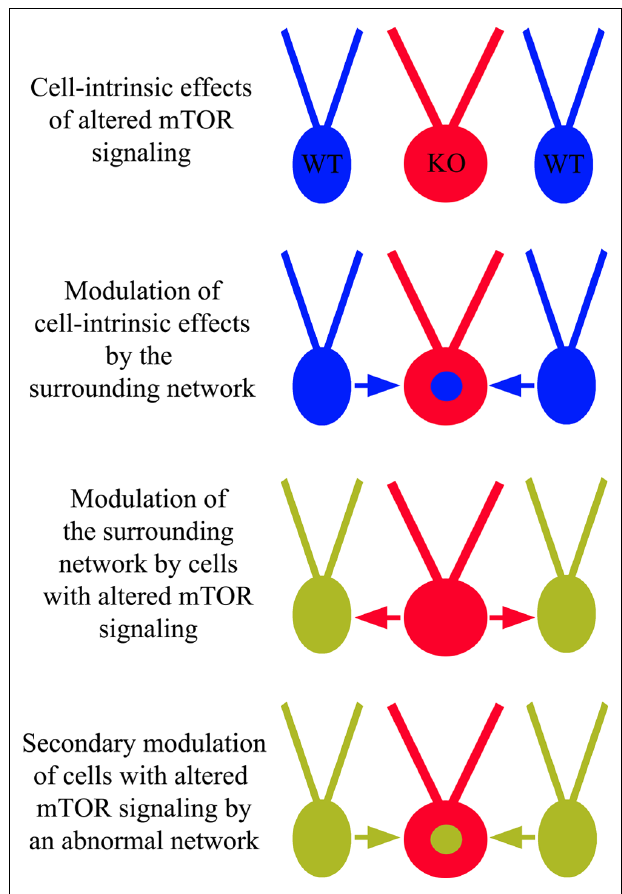
FIGURE 6 | Cell-intrinsic effects of altered mTOR signaling and network influence. In addition to cell-intrinsic effects from disrupted mTOR signaling in cells lacking PTEN,TSC1, orTSC2 (red “KO” cells), these cells may respond inappropriately to surrounding wild type (WT) cells and/or causeWT cells to behave abnormally.These altered dynamics may produce an abnormal network, facilitating